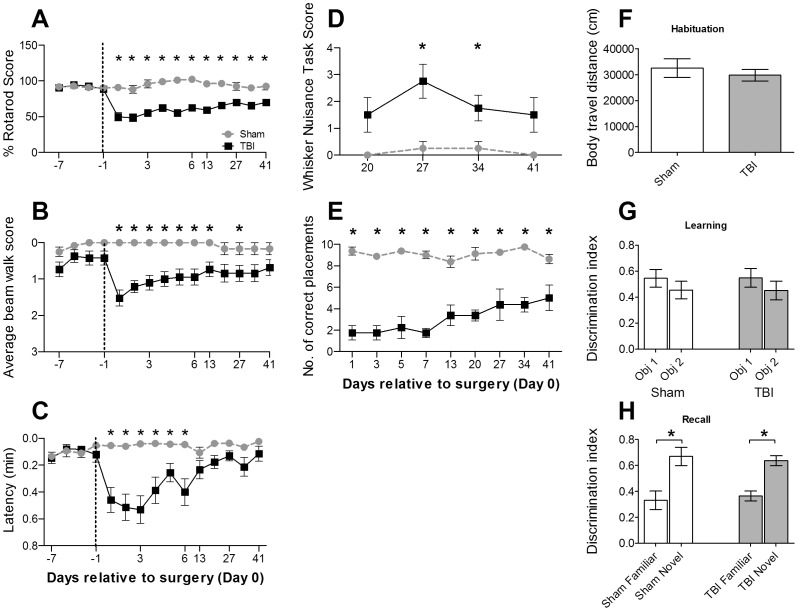
Sensori-motor deficits following diffuse traumatic brain injury (TBI).(A)–(C): Changes in behaviour from prior to treatment and up to 6 weeks post- treatment. In all panels the dotted line separates pre- (days −7 to −1) and post-surgery periods (days 1 to Week 6) for Sham (n = 12) and TBI (n = 19) groups. (A) Grip strength and motor co-ordination: Rotarod performance for each animal was expressed as a percentage of maximum pre-trauma rotarod score. This was averaged across all animals in Sham and TBI groups. (B) Balance and motor co-ordination: Beam-walking scores expressed as the average score for balance on the beam and ability to walk across it in Sham and TBI groups. (C) Manual dexterity: Adhesive tape removal latencies, expressed as average time in minutes to remove the first adhesive tape from the forepaws. (D)–(E): Effects of impact brain injury on whisker-based sensori-motor tests. Only post-treatment data were obtained for these tests in Sham (n = 4) and TBI (n = 4) groups. (D) Whisker-evoked forepaw placement. Correct forepaw placements (out of 10) averaged across left and right forepaws in Sham & TBI groups over 6 weeks post-trauma. (E) Whisker nuisance task scores. Total scores for Sham and TBI groups in the whisker position, response to stick presentation, and grooming components of whisker nuisance task. Scores were recorded from weeks 3 to 6. (F–H) Novel Object recognition Test (NORT), of learning and memory. The number of animals in the two groups was Sham n = 12 and TBI n = 19. (F) Distance travel during habituation period. Average distance (in centimetres) travelled. (G) Discrimination index of object exploration during learning period. Proportion of total time spent on exploring two identical objects (Obj 1 and 2). (H) Discrimination index on exploring familiar and novel objects during recall trial. Proportion of total time spent on exploring a familiar and novel object. * represents a significant difference of p<0.05. All values are mean ± SEM.